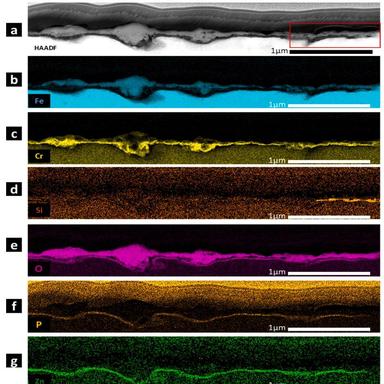
The HAADF-STEM images of the cross section of the PCC-treated sample (a) and the corresponding EDX maps of Fe, Cr, Si, O, P, and Zn (b-g).